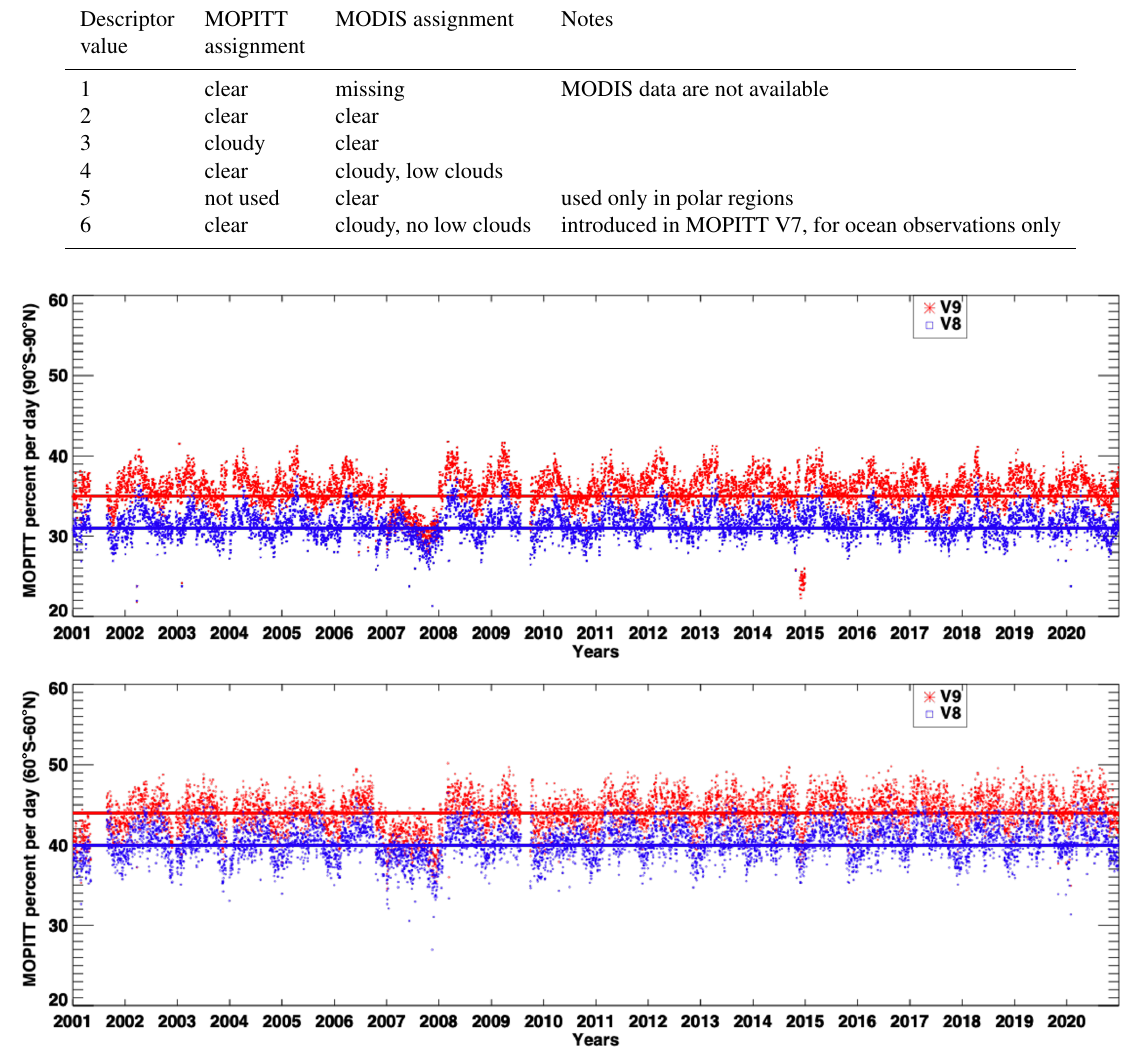
Figure 1. The percentage of successful daily MOPITT retrievals between 90 ◦ S–90 ◦ N and 60 ◦ S–60 ◦ N from 2000 to 2020 for V9 and V8. The solid lines represent the average successful retrieval for the entire